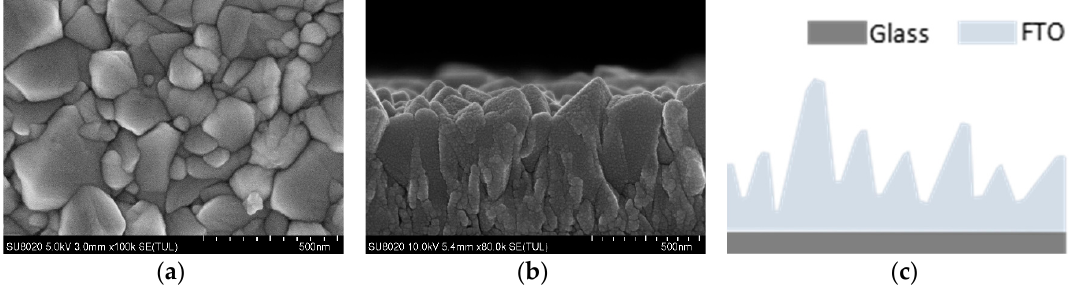
Figure 2. SEM images of top view ( a ), cross section ( b ), and schematic diagram ( c ) of the rough surface of the FTO substrate.